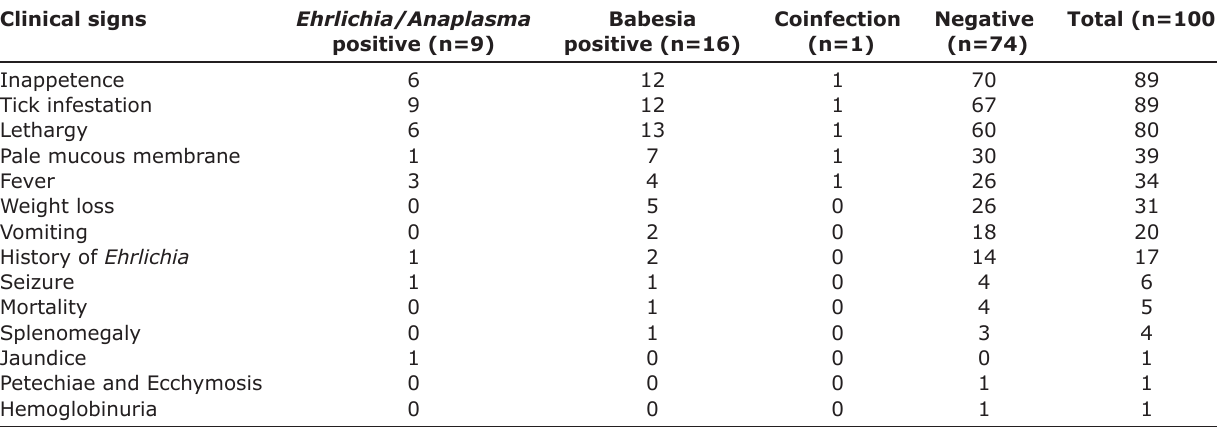
Table-1: Clinical signs of dogs PCR positive for Ehrlichia/Anaplasma and/or Babesia spp. in Cebu, Philippines (n=100). Clinical signs